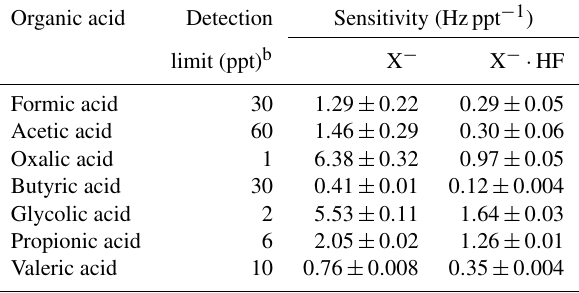
Table 1. Summary of organic acids of interest, their detection limits and sensitivities of their X − and X − · HF ions a